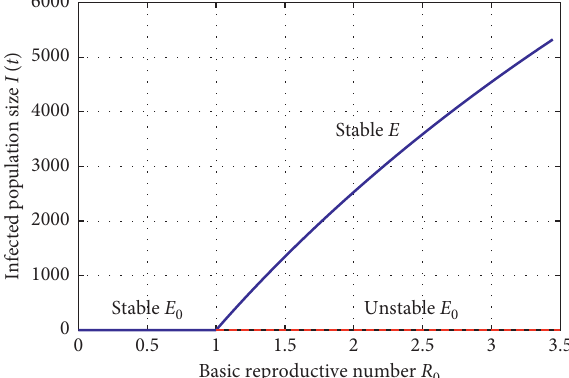
Figure 2: Forward bifurcation of the dynamical system in equation (1) at R